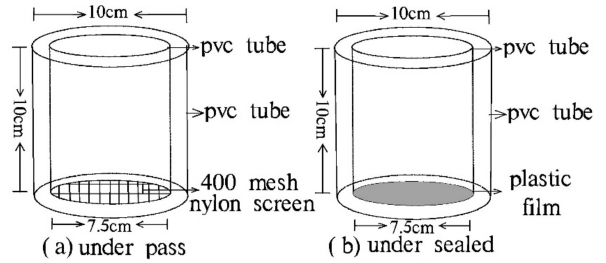
Figure 1. Experimental setup ( a ) is the under pass tube. PVC pipe with a diameter of 7.5 cm is used as the inner cylinder and PVC pipe with a diameter of 10 cm is used as the outer cylinder. The